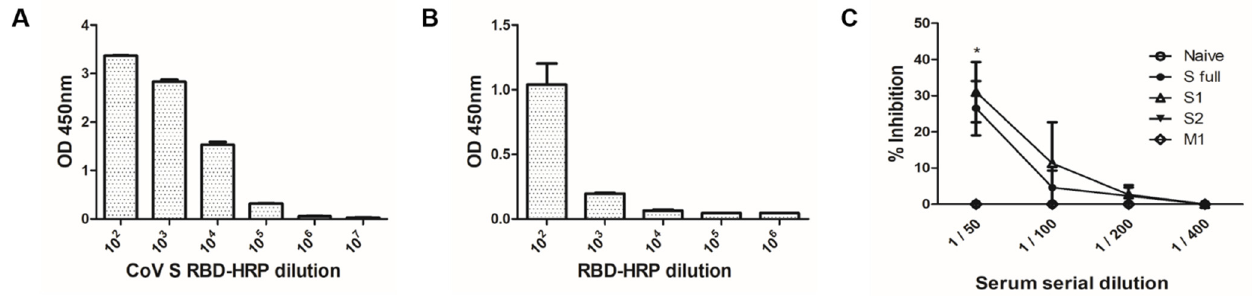
Figure 7. Surrogate virus neutralization requires the presence of S1 domain. Confirmation of HRP conjugation to S RBD ( A ) and successful RBD-HRP interaction with the hACE2 ( B ) was assessed through ELISA. Surrogate virus neutralization assay was conducted using serially diluted sera of immunized mice after heat-inactivation ( C ). Data are expressed as mean ± SEM (* p < 0.05 vs. naïve control).